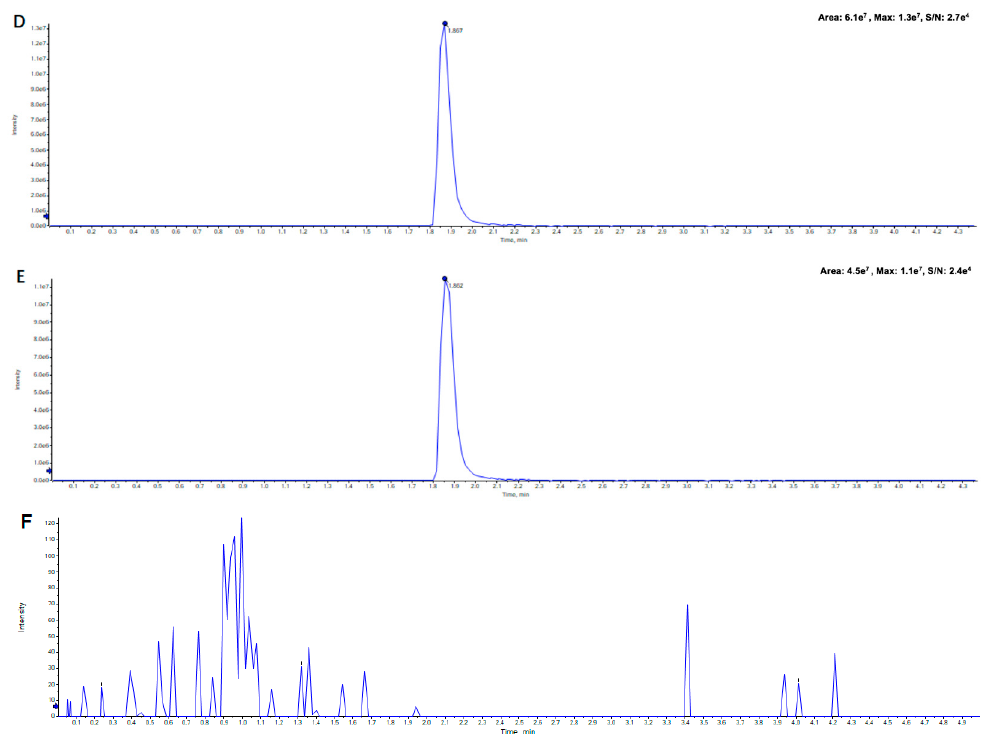
Figure 3. Typical chromatograms of ( A ) standard osimertinib (20 ng/mL) in rat plasma, ( B ) pharmacokinetic plasma sample, ( C ) blank plasma, ( D ) standard ion of sorafenib (IS) (500 ng/mL) in rat plasma, ( E ) pharmacokinetic plasma sample, and ( F ) blank plasma.